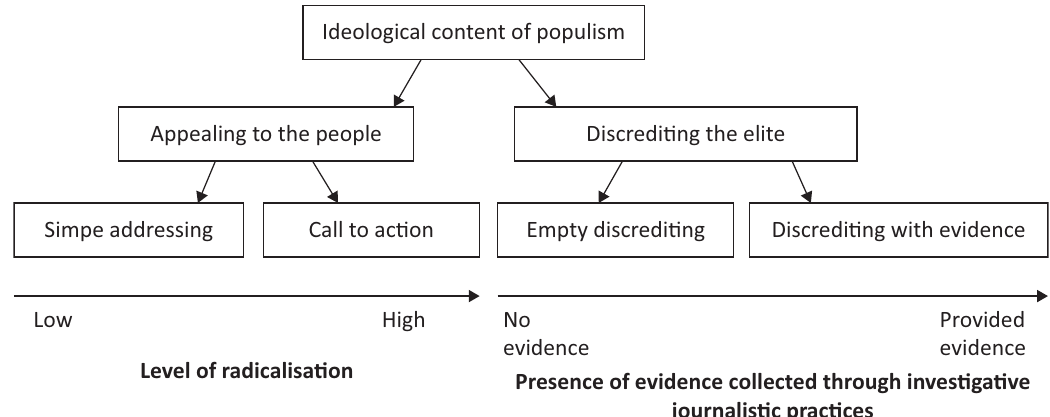
Figure 1. Ideological elements of populism in Navalny’s videos: Categories for coding. Table 1. Types of populisms in Navalny’s narration based on the combination of populism sub-categories. Discrediting the elite/appeal to ‘the people’ Simple addressing Call to action Empty discrediting Discrediting with